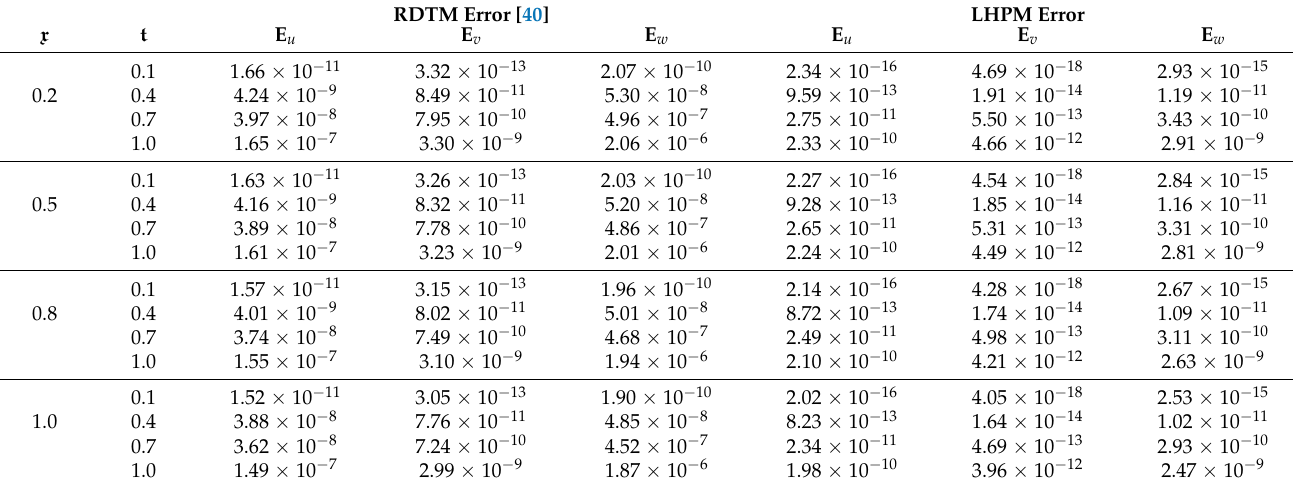
Table 5. Comparison of LHPM and RDTM errors in Example 3 when β = 1, α = 0.1, c 0 = 1.5 and c 2 = p = 0.5 (where E u , E v and E w represent errors of U , V and W , respectively).